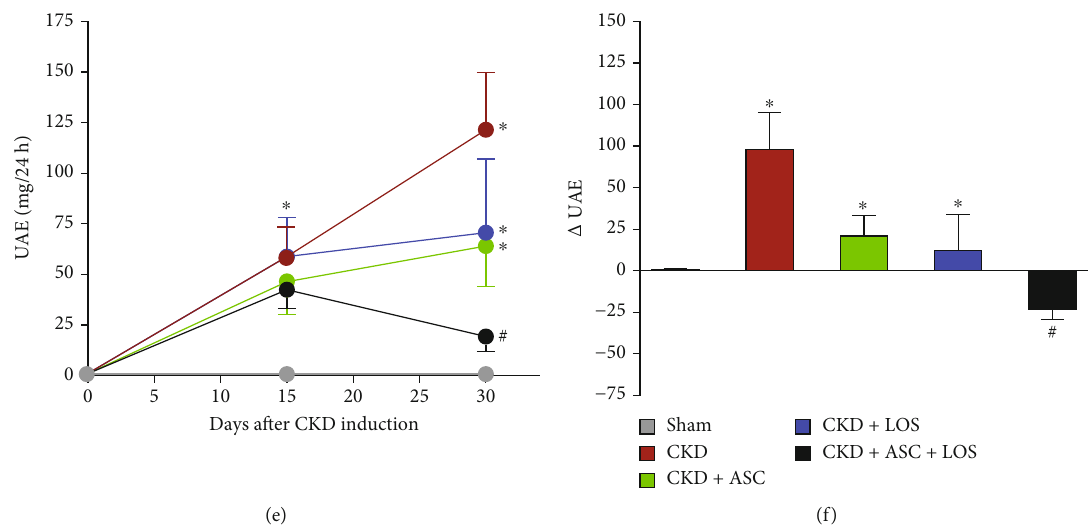
Figure 1: Systolic blood pressure (SBP, mmHg), urinary protein (UPE, mg/24h), and albumin (UAE, mg/24 h) excretion of the animals of each experimental group: (a) SBP; (c) UPE; (e) UAE time-course graphs. (b) SBP, (d) UPE, and (f) UAE delta bar graphs are obtained by subtracting the values observed at 30 days from those obtained at 15 days, before the beginning of treatments. Statistical di ff erences are ∗ p < 0 : 05 vs. Sham, # p < 0 : 05 vs. CKD, † p < 0 : 05 vs. CKD+ASC, and ‡ p < 0 : 05 vs. CKD+LOS, in the respective time